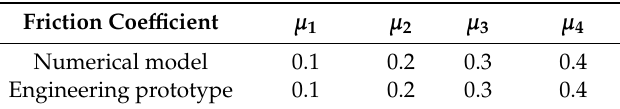
Table 4. The parameter selection of friction coe ffi cient.